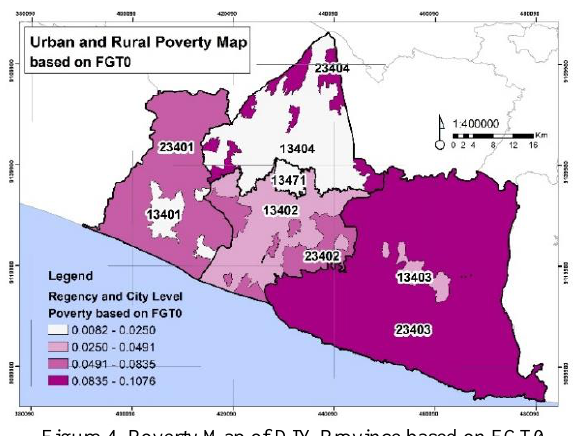
Figure 4. Poverty Map of DIY Province based on FGT0